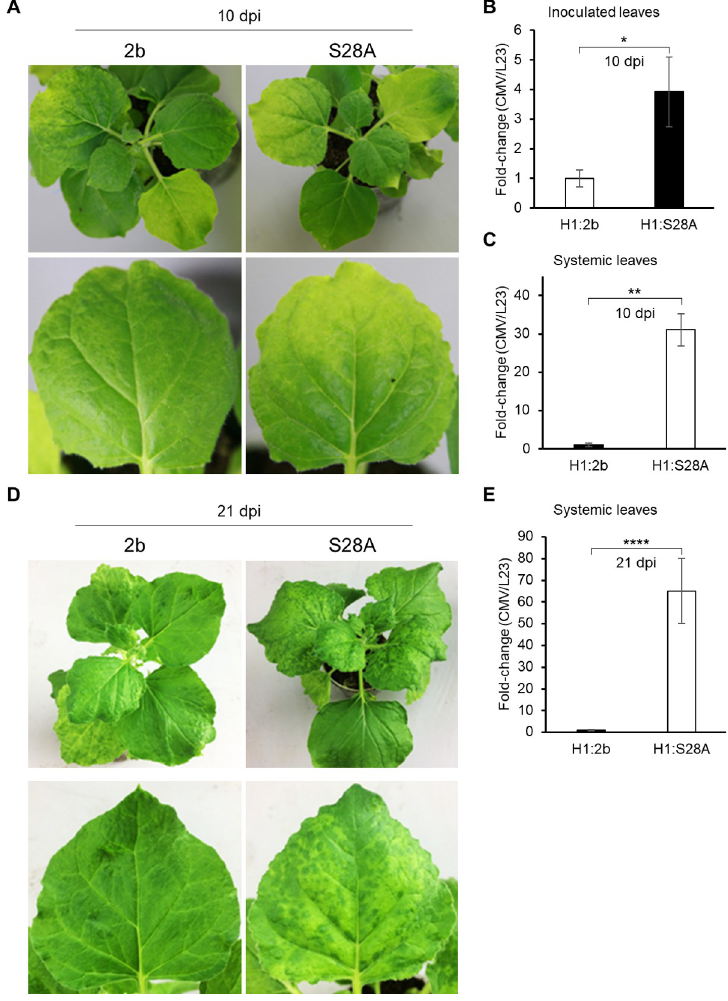
Fig 5. Effect of alanine substitution at S28 on CMV disease severity. (A) CMV symptoms on N . benthamiana 10 days post inoculation (dpi) with CMV containing S28A at early stage of infection. Wild-type 2b and S28A genes were inserted into the CMV-H1 vector (H1:2b and H1:S28A). CMV RNA levels based on real-time RT-PCR in inoculated (B) and systemically infected (Systemic) leaves (C). Means ( ± SE) are fold-changes, calculated when the value of H1:2b is set to 1.0, and tested on log-transformed data for a significant difference using Student’s t -test ( � P < 0.05 or �� P < 0.01). (D) Disease severity induced by 2b and 2b-S28A and (E) CMV RNA levels based on real-time qRT-PCR in systemically infected upper leaves at 21 dpi. Mean values ( ± SE) are fold-changes and statistically analyzed as above ( ���� P <